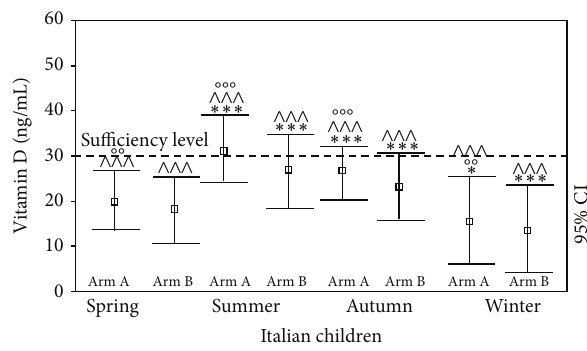
Figure 4: Seasonal variation in 25(OH)D levels (ng/mL) in Italian children and adolescents with 25(OH)D deficiency after cholecal- ciferol supplementation (Arm A) or implementation of the factors influencing 25(OH)D status (Arm B) at 𝑇 1 (versus spring value and versus 𝑇 0 evaluation). ∗ 𝑃 < 0.05 ; ∗∗ 𝑃 < 0.005 ; ∗∗∗ 𝑃 < 0.001 versus spring value. ∧ 𝑃 < 0.05 ; ∧∧ 𝑃 < 0.005 ; ∧∧∧ 𝑃 < 0.001 versus 𝑇